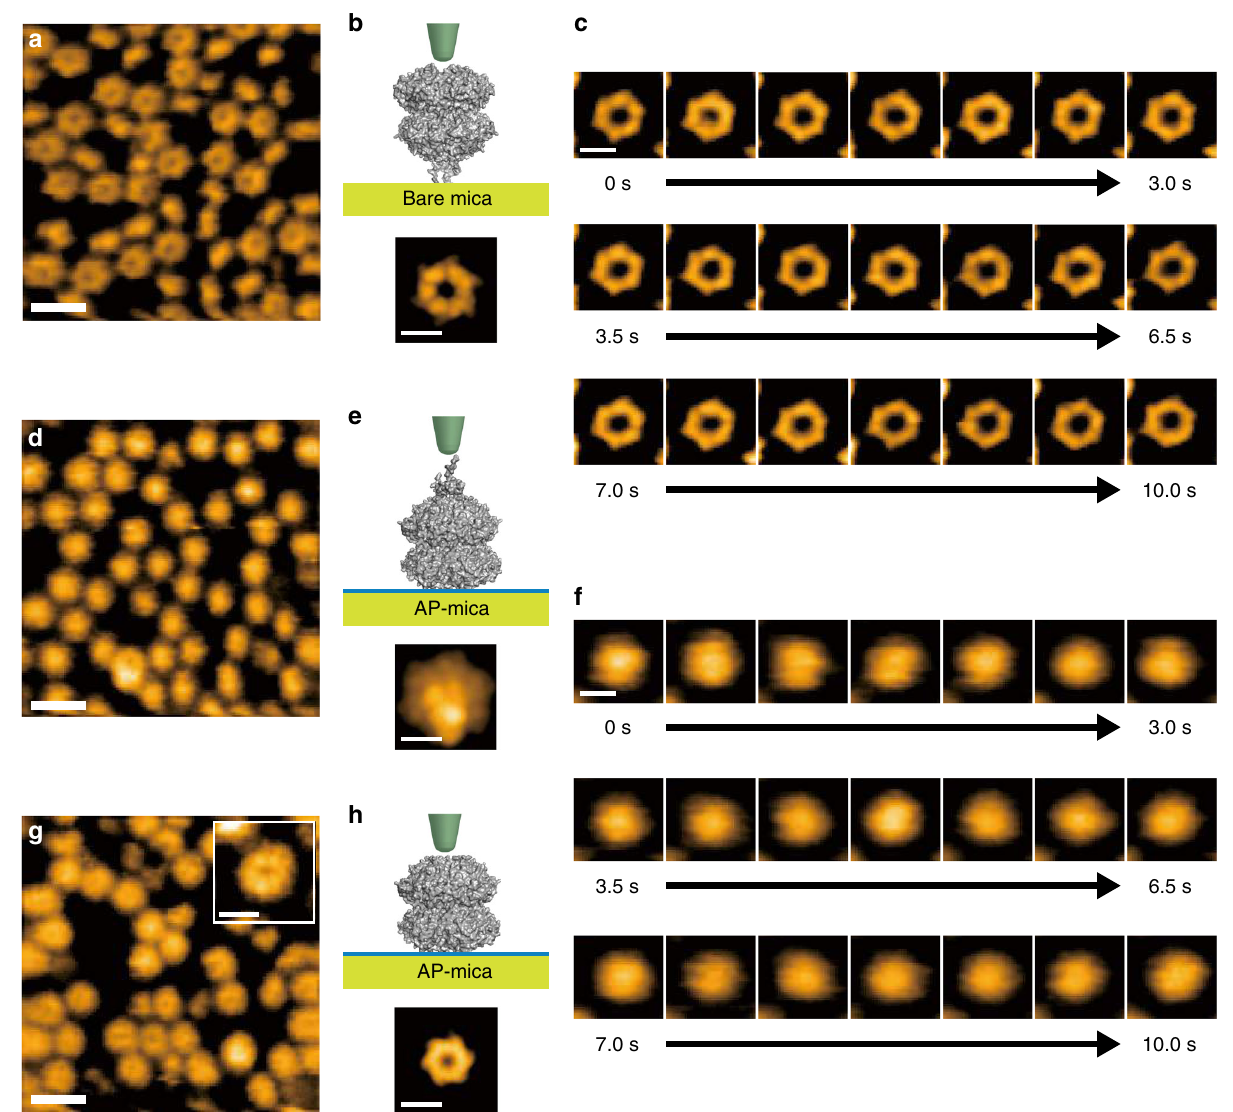
Fig. 2 HS-AFM images of KaiC WT hexamers. a HS-AFM images of native KaiC WT hexamers immobilized on bare mica. Scale bar = 15 nm. b Simulated AFM image of KaiC (bottom) viewed from the N-terminal side. This construction was made using a hypothetical probe with a radius of 0.5 nm and a cone angle of 10°, as illustrated (top). Scale bar = 5 nm. c Time lapse images of KaiC WT hexamers attached to bare mica, which visualizes the N-terminal side of KaiC hexamers in the presence of 2 mM Mg 2 + -ATP. Images were acquired at a frame rate of 2 fps and images taken every 0.5 s are shown. Scale bar = 5 nm. d HS-AFM image of native KaiC WT hexamers immobilized on AP-mica. Scale bar = 15 nm. e Simulated AFM image of KaiC (bottom) viewed from the C- terminal side. This construction was made using a hypothetical probe with a radius of 0.5 nm and a cone angle of 10°, as illustrated (top). Scale bar = 5 nm. f Time lapse images of KaiC hexamers attached to AP-mica. The images show the C-terminal side of KaiC WT hexamers in the presence of 2 mM Mg 2 + -ATP. Imaging was carried out at a frame rate of 2 fps and images every 0.5 s are shown. Scale bar = 5 nm. g HS-AFM images of KaiC- Δ C hexamers (in which the C-terminal tentacles are truncated), immobilized on bare mica. Scale bar = 15 nm. The insert is an enlarged image (scale bar within insert =